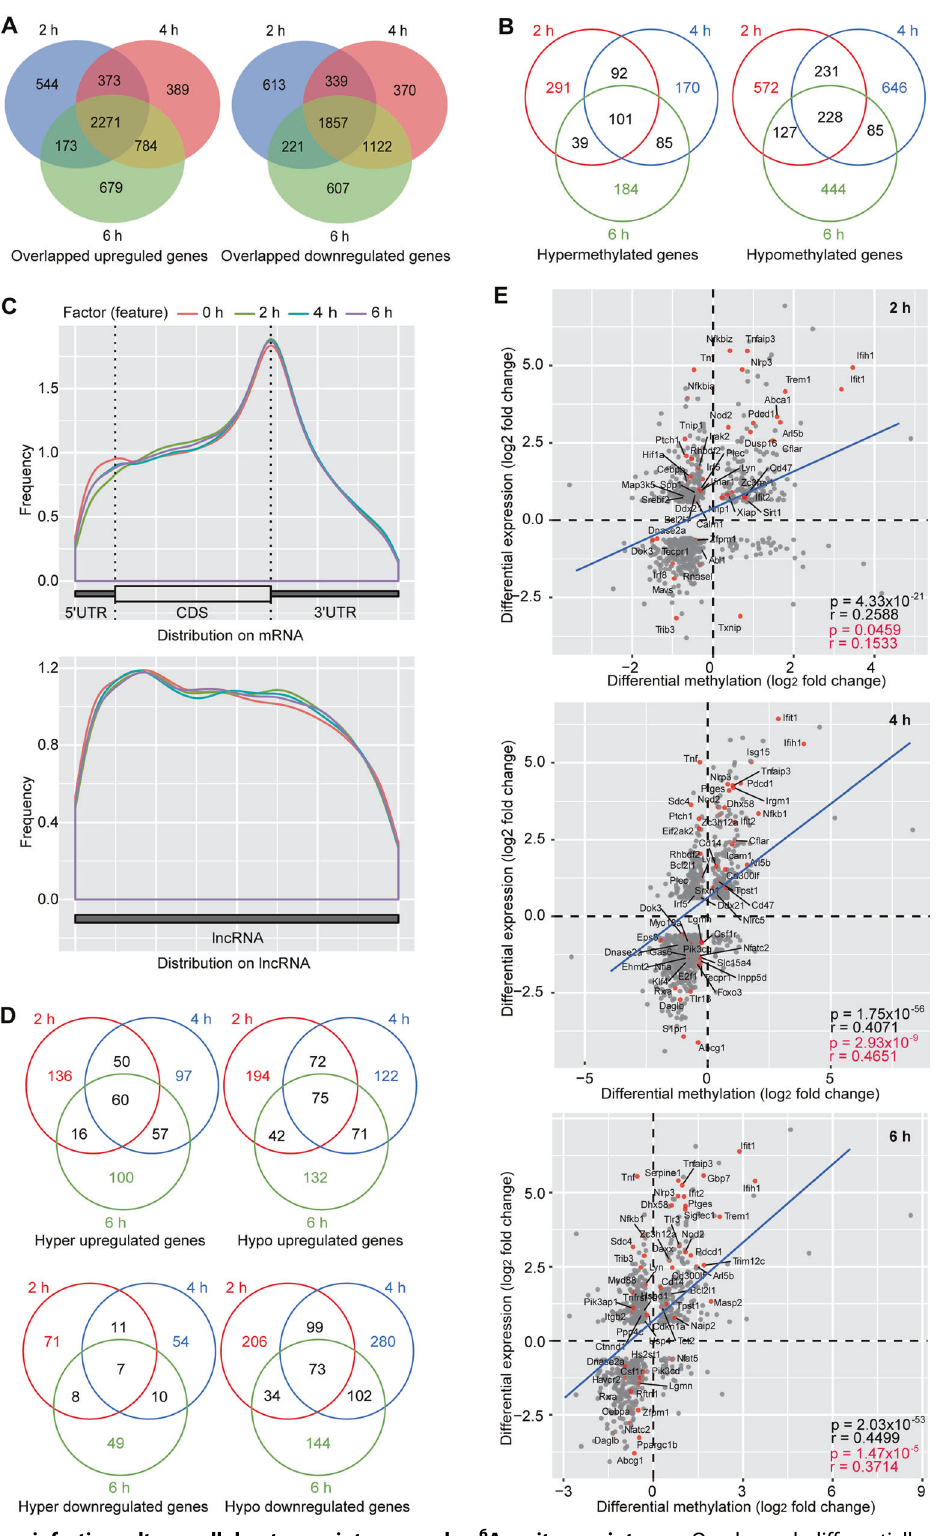
Fig. 1 P. aeruginosa infection alters cellular transcriptome and m 6 A epitranscriptome. Overlapped differentially expressed ( A ) and methylated ( B ) genes following P. aeruginosa infection for 2, 4 and 6 h. C Overall m 6 A distribution on cellular mRNA and lncRNA at different time points following P. aeruginosa infection. D Overlapped differentially expressed genes with hypermethylation and hypomethylation following P. aeruginosa infection for 2, 4 and 6 h. E Correlation of mRNA expression level and m 6 A level for differentially expressed and methylated genes at 2, 4 and 6 h P. aeruginosa post-infection. The regression lines are marked in “ blue ” . Innate immune related genes are marked with “ red dots ” .